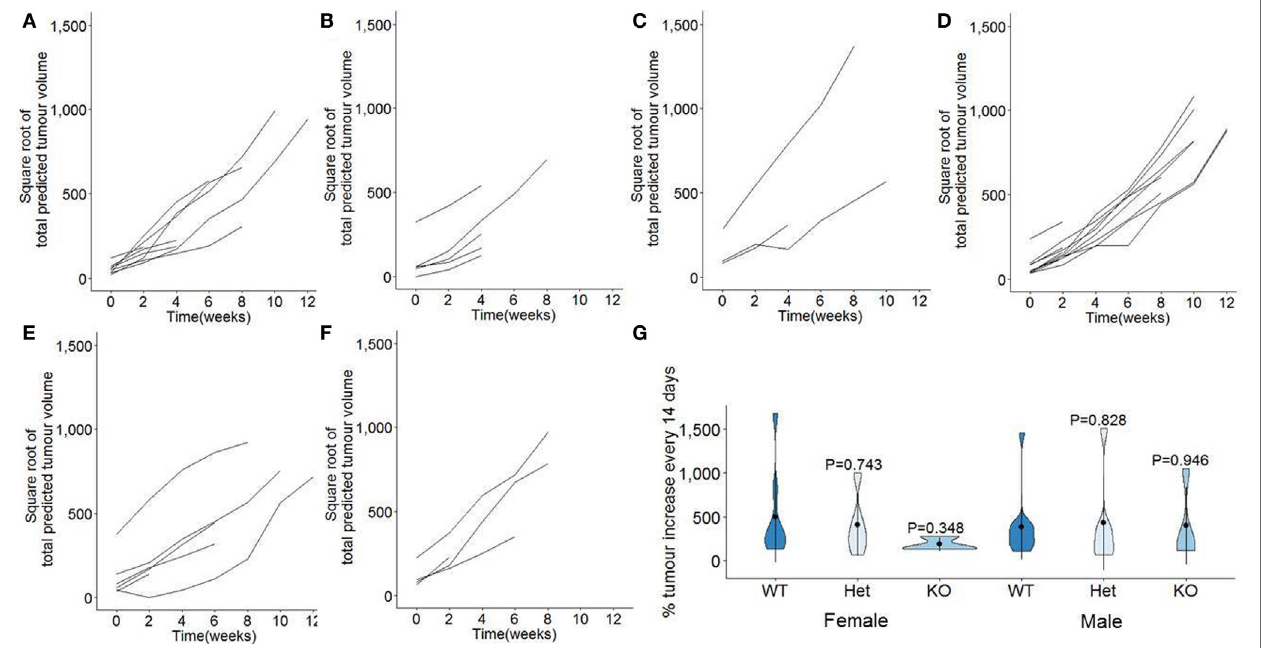
FigUre 4 | Tumor growth rates are unaffected in miR-342 knockout mice using a pancreatic cancer model . TAg + , miR-342 + /0 TAg + , and miR-342 0/0 TAg + mice were monitored longitudinally by magnetic resonance imaging for tumor load and size, from 7 weeks of age until 21 weeks of age. Total tumor volumes were square root transformed, with plots showing individual growth in total tumor burden from point of first detection in (a) TAg + female mice ( n = 10), (B) miR-342 + /0 TAg + female mice ( n = 8), (c) miR-342 0/0 TAg + female mice ( n = 6), (D) TAg + male mice ( n = 13), (e) miR-342 + /0 TAg + male mice ( n = 6), and (F) miR-342 0/0 TAg + male mice ( n = 4). (g) Violin plots for the percentage tumor volume increase per 2 weeks, averaged from time of detection to death. Mean, standard deviation, and kernel probability